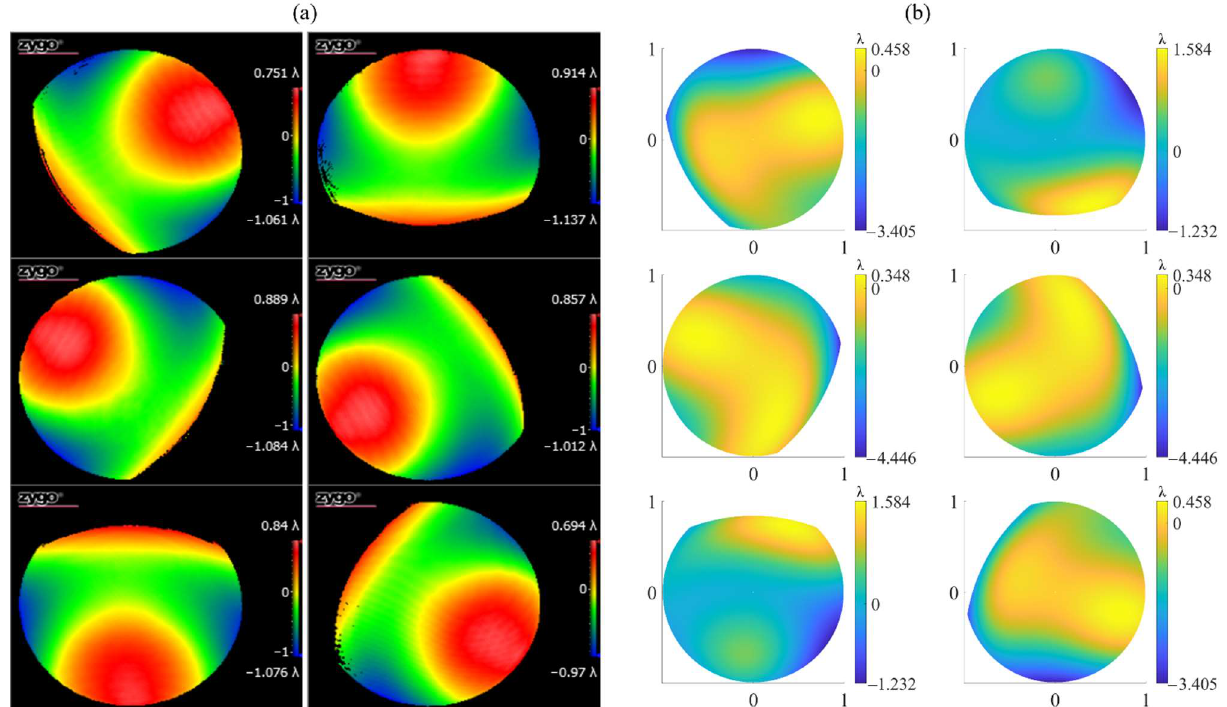
Figure 14. Wavefront maps of the off-axis subapertures in the ( a ) real interferometer and ( b ) virtual interferometer.